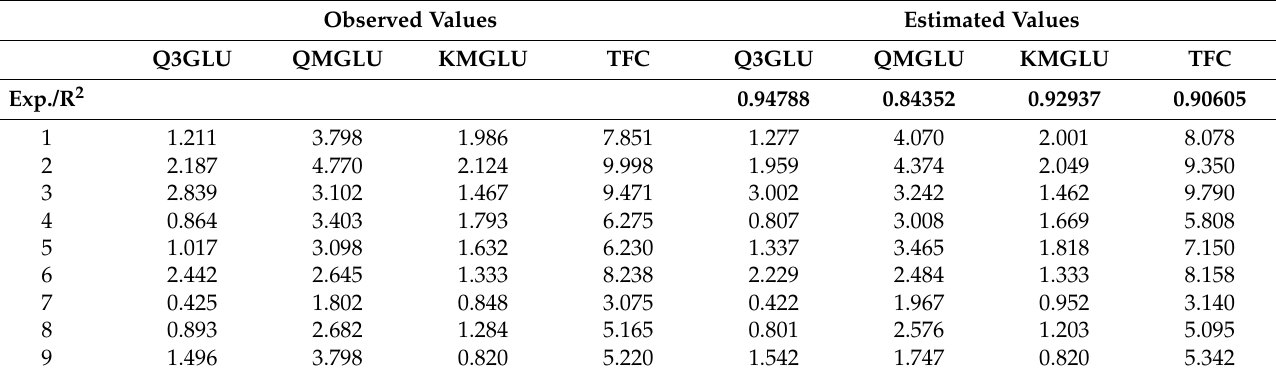
Table 3. Experimental values (mg g − 1 sample) vs. design-estimated values (mg g − 1